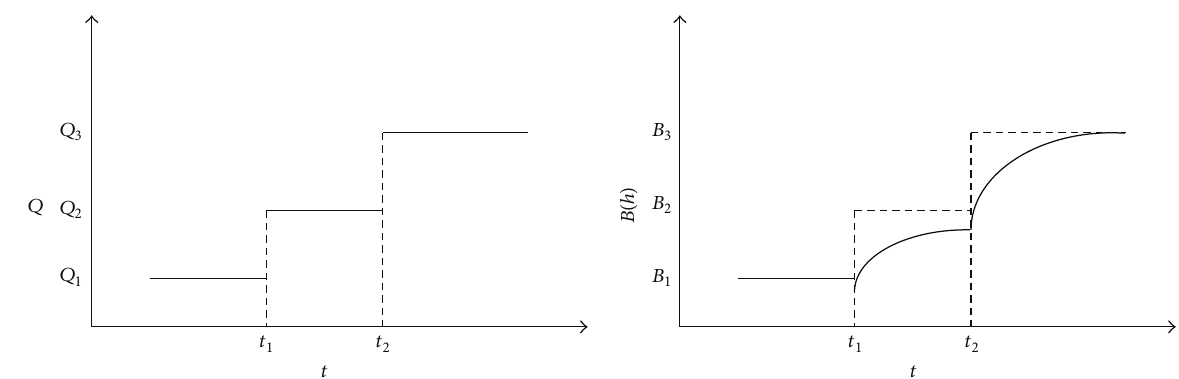
Figure 8: Channel response processes for the change of water and sediment flow.